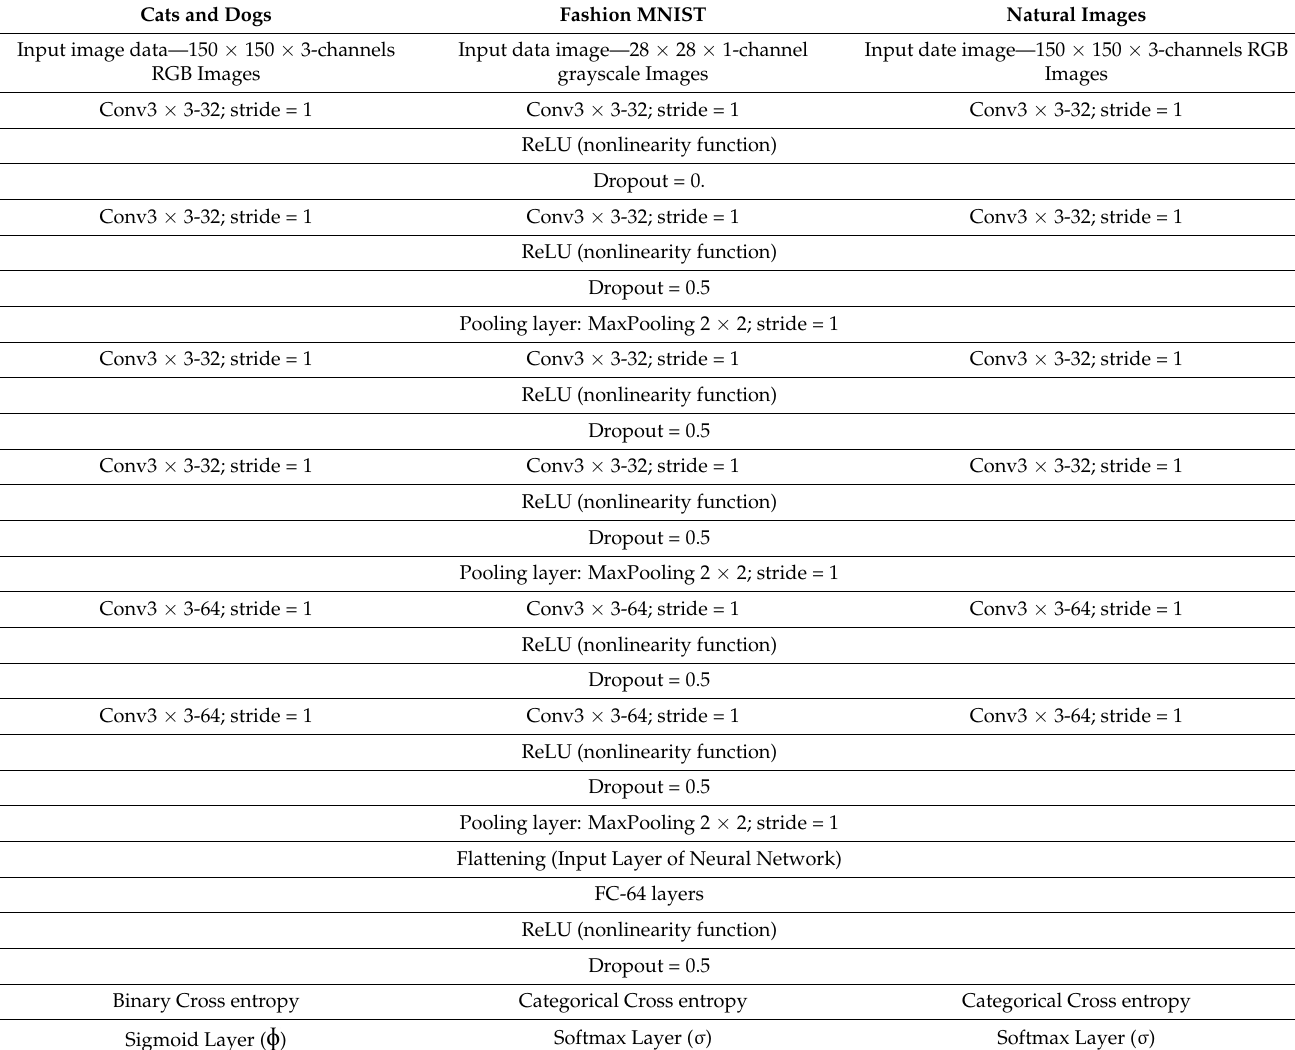
Table 5. Configuration summary of CNN with increasing depth denoted as d CNN. Table 7. Configuration summary of CNN with increasing depth and width denoted as d/w CNN.